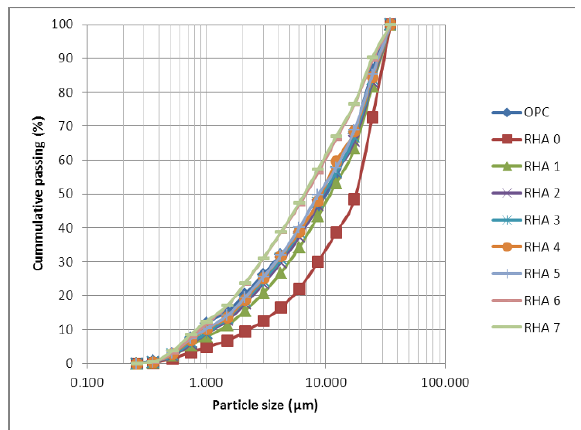
RHA7, respectively. Rice husk ash can have significant reduction in permeability of normal concrete [20]. The